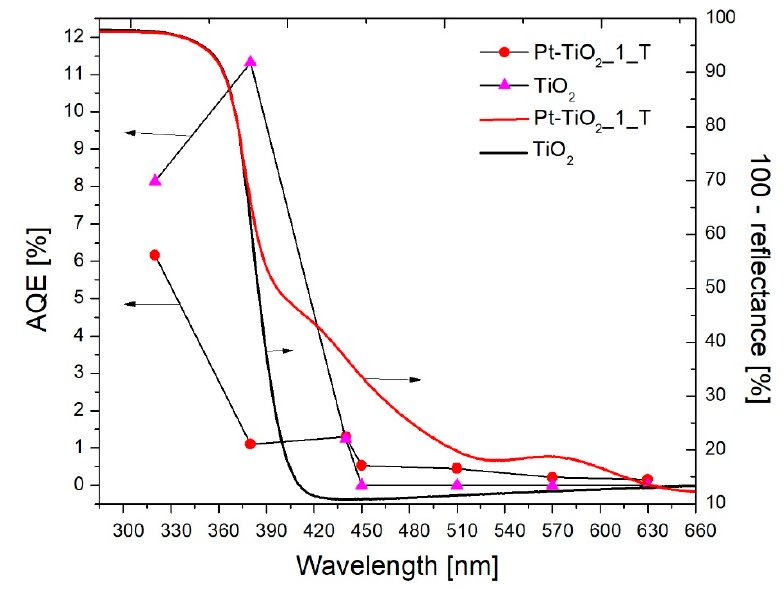
Figure 7. Spectral activity and absorption spectra in phenol oxidation for TiO 2 and Pt-TiO 2 _2_T. (AQE—Apparent Quantum Efficiency).